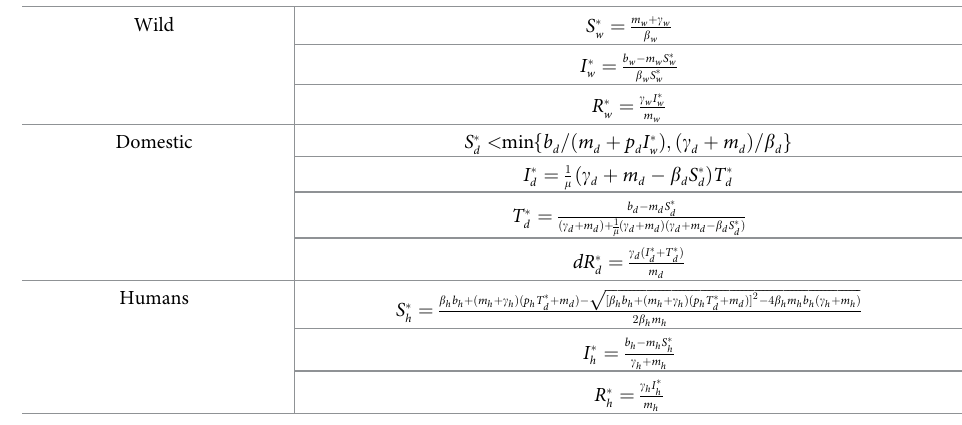
Note that this approach also gives a distinct reproduction number for each strain in each species: we can define the original pathogen’s reproduction number as R w